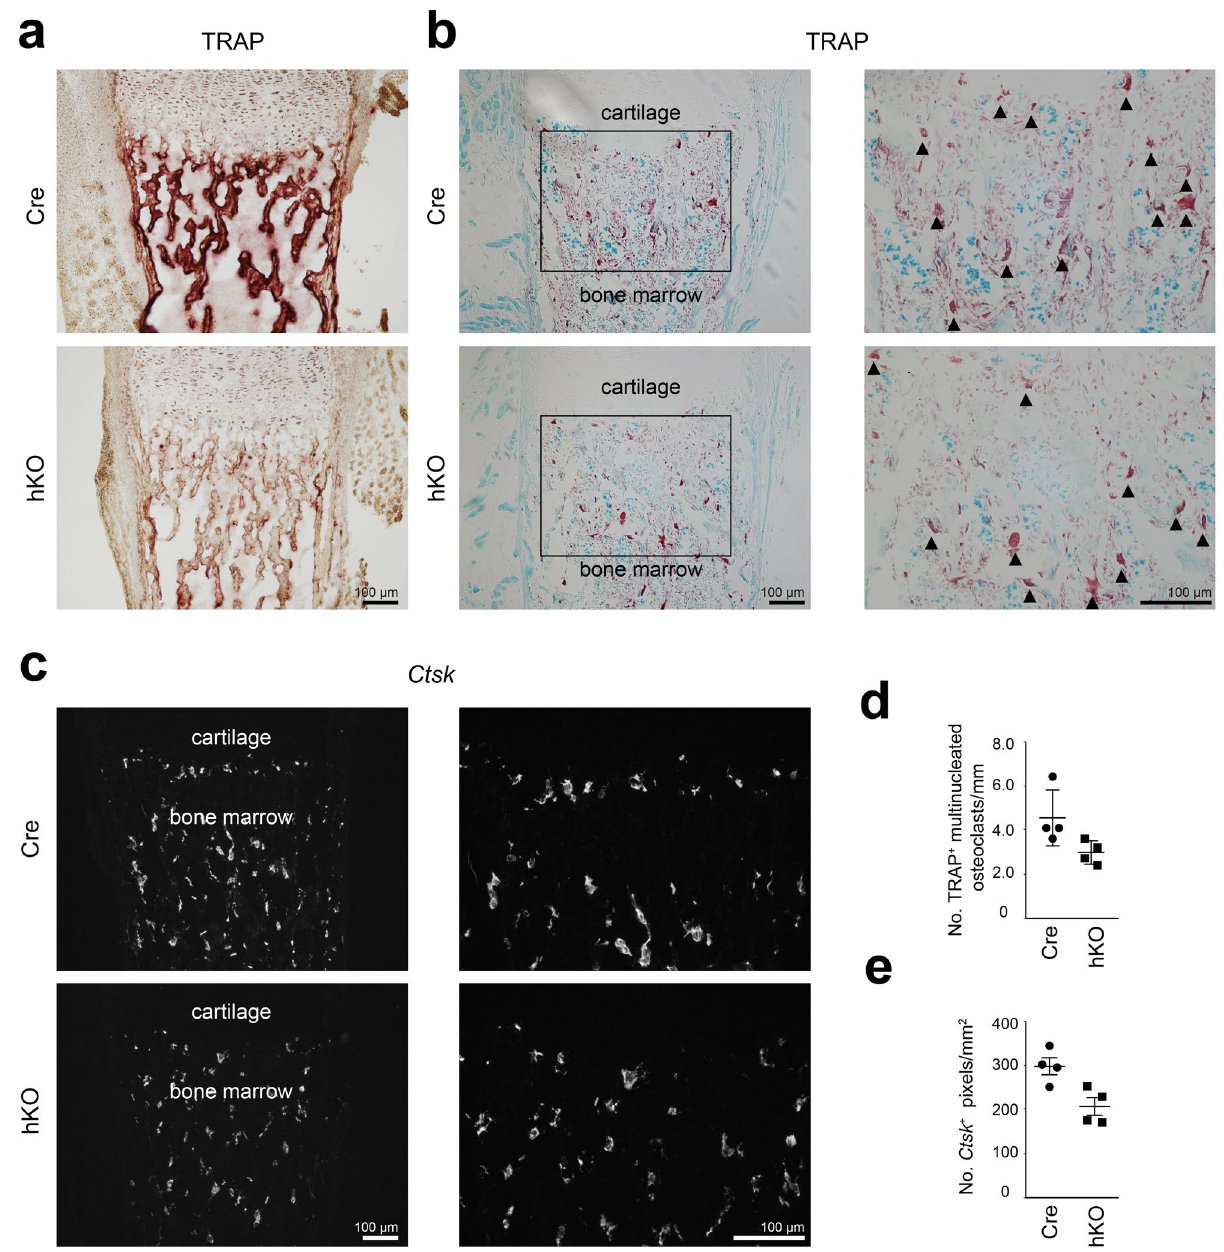
Figure 4. Characterization of osteoclast organization in femoral sections from Mirc24 cluster-deficient mice. ( a ) To identify osteoclasts, tartrate-resistant acid phosphatase (TRAP) activity stainings were performed on frozen sections of femora from newborn male Col2a1-Cre (Cre) and Col2a1-Cre- Mirc24 tm1M/Y (hKO) mice. ( b ) To determine osteoclast numbers, TRAP activity (red) was detected in paraffin sections counterstained by Fast green (blue). Enlarged area is indicated by a box. Multinucleated osteoclasts are marked by arrowheads. ( c ) Ctsk mRNA distribution was analyzed by fluorescence in situ hybridization using a Ctsk specific fluorescence probe. Brightness was adjusted for visualization ( b , c ) using Adobe Photoshop Elements 2020 (Version 18.0, https:// www. adobe. com/ produ cts/ photo shop- eleme nts. html). Four animals per genotype were analyzed and representative images are shown. Additional images are shown Supplementary Figs. S5 and S6 online. For quantification ( d ), the number of TRAP + multinucleated osteoclasts per mm trabecular bone in ( b ) was determined and ( e ) the number of Ctsk + particles per mm 2 in ( c ) was calculated. Individual and mean values and standard deviations are shown (graph). The figure was created using Adobe Illustrator CS6 (Version 16.0.3, https:// adobe. com/ produ cts/ illus